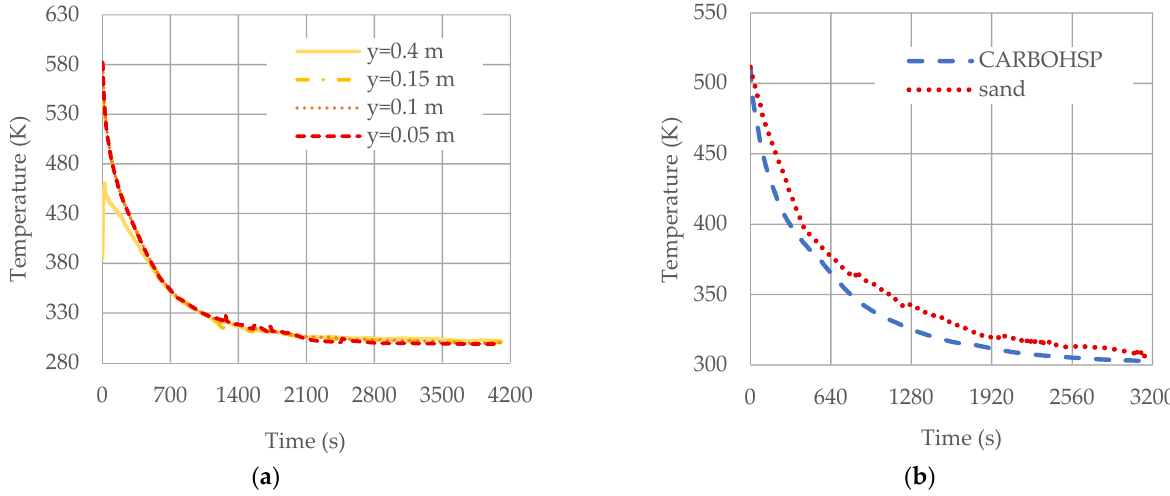
Figure 7. ( a ) Variation of the air temperature in the experimental study at different elevations with u = 0.46 m/s; ( b ) variations in the air temperature of an FB containing sand and CARBOHSP particles at y = 0.10 m with u = 0.38 m/s.